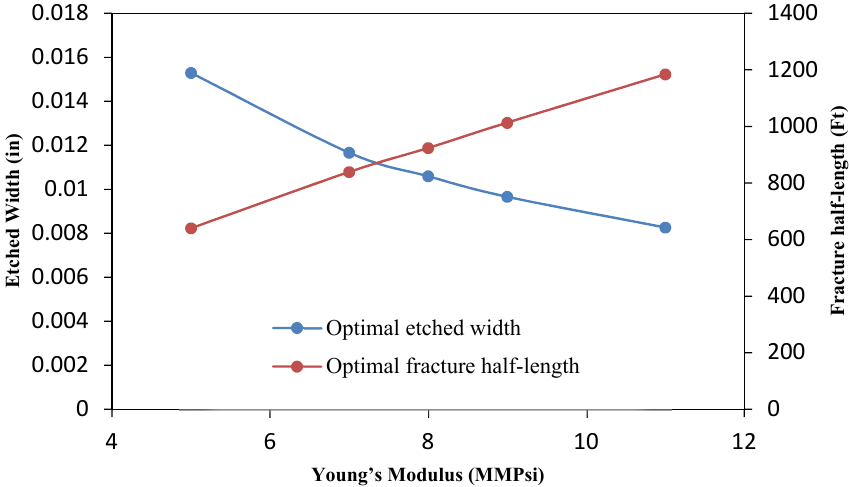
Figure 18. Optimal fracture half-length and etched width vs. Young’s modulus.